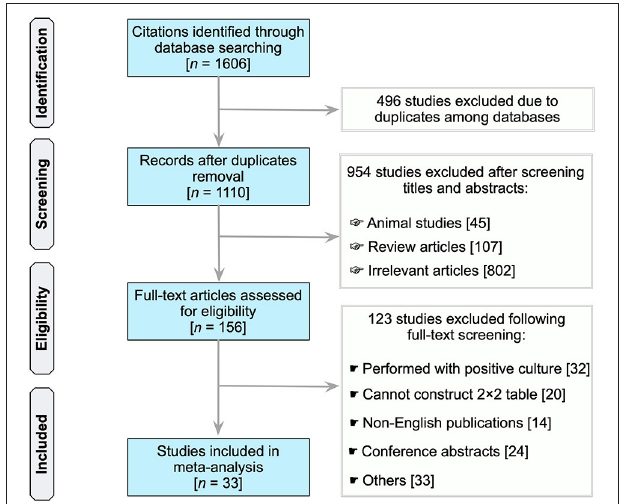
FIGURE 1 | Flow chart of study